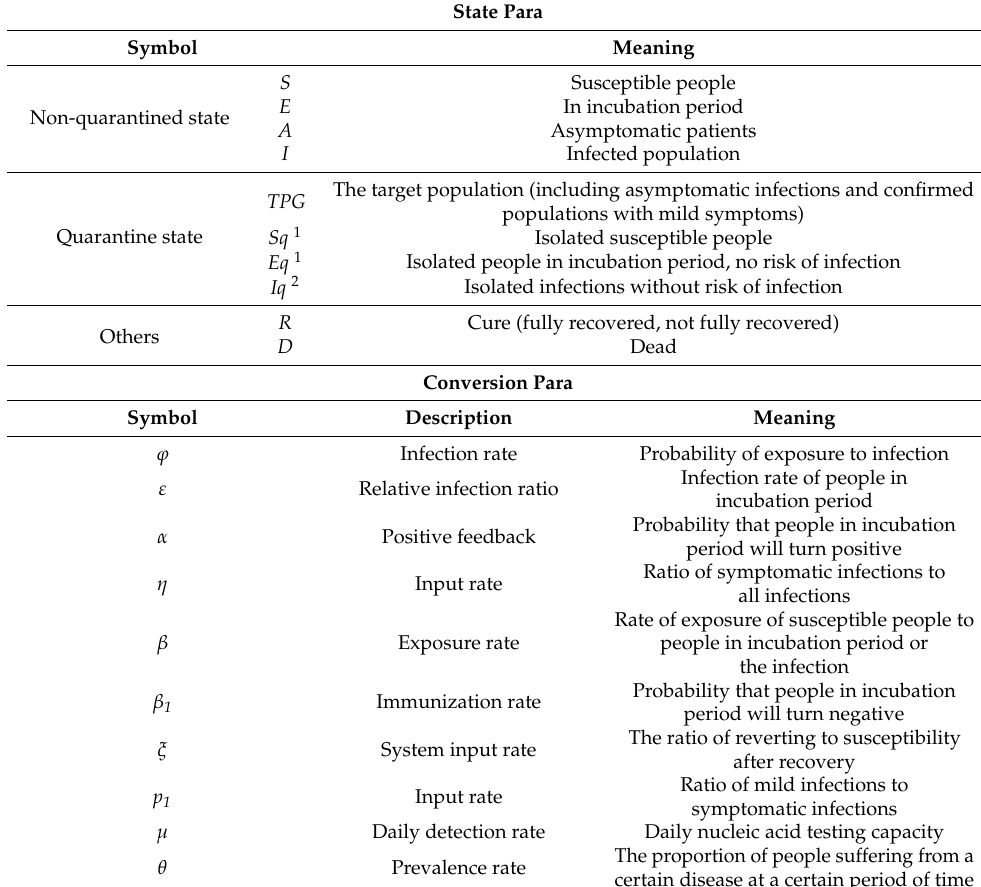
Table 2. Parameter Definition and